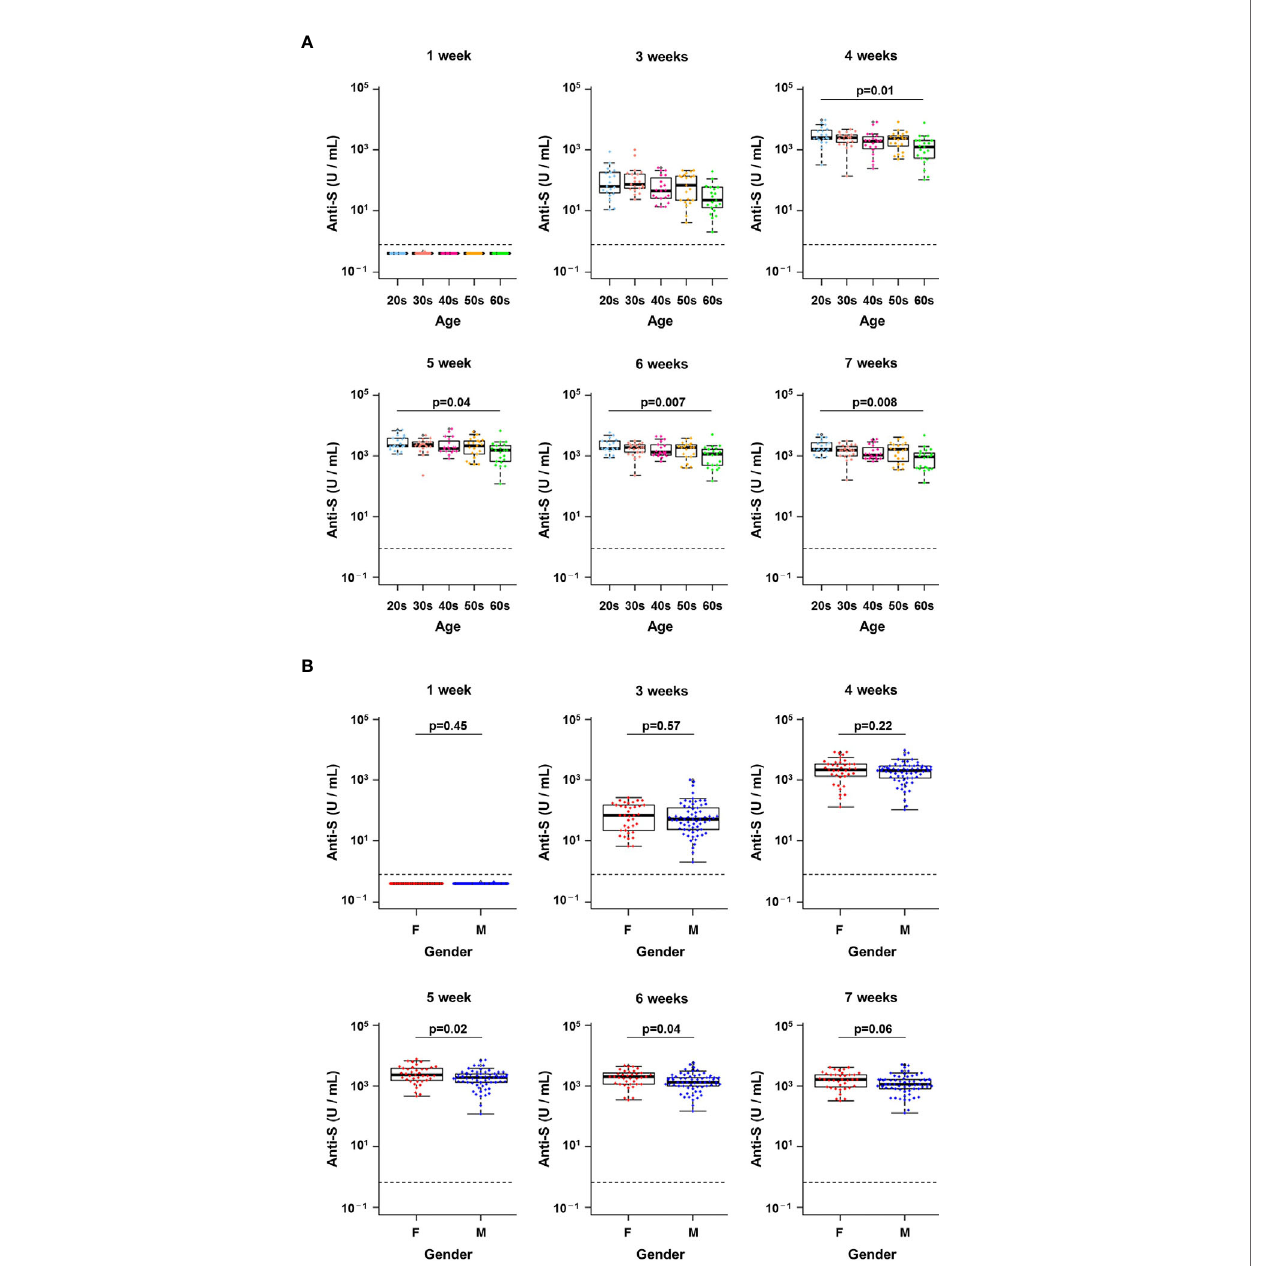
FIGURE 3 | Changes in antibody titres at each week post-vaccination in infection-naïve healthcare workers. (A, B) Changes in the titres of anti-spike (S) antibodies from week 1 to week 7 after the fi rst vaccine dose by age group (A) and by gender (B) . A pairwise t-test with Bonferroni correction was conducted for the multiple comparison test across the age groups. Student ’ s t-test was performed for statistical analyses between female (F) and male (M). The dotted line indicates the cut-off value (0.8